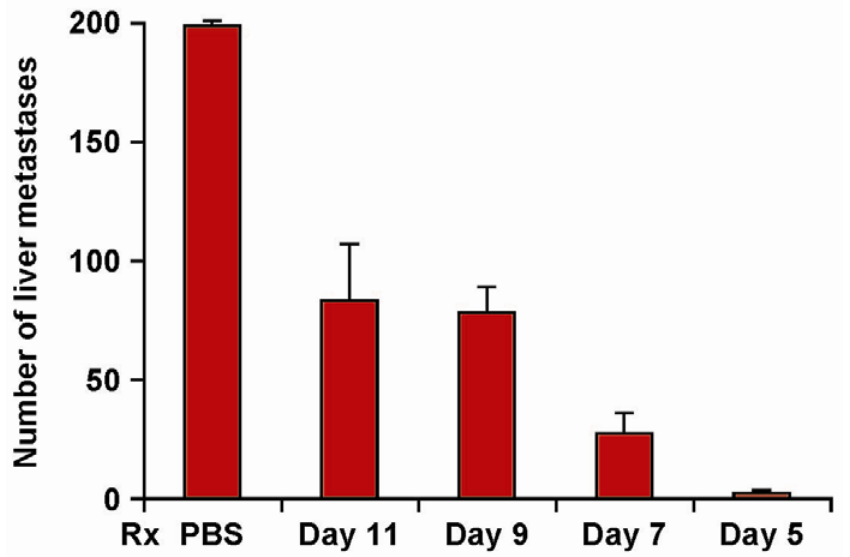
Figure 2. Efficacy of hu14.18-IL2 therapy is influenced by the timing of its initiation. Groups of 4 mice were treated IV with 5 µg/day × 5 days of hu14.18-IL2 beginning on d 5, 7, 9 or 11 following IV injection of 5 × 10 5 NXS2 NB cells (or IV PBS). Mice were sacrificed on d28 and the liver metastases were enumerated. Data are mean ± SE (adapted from Neal et al. , 2004,